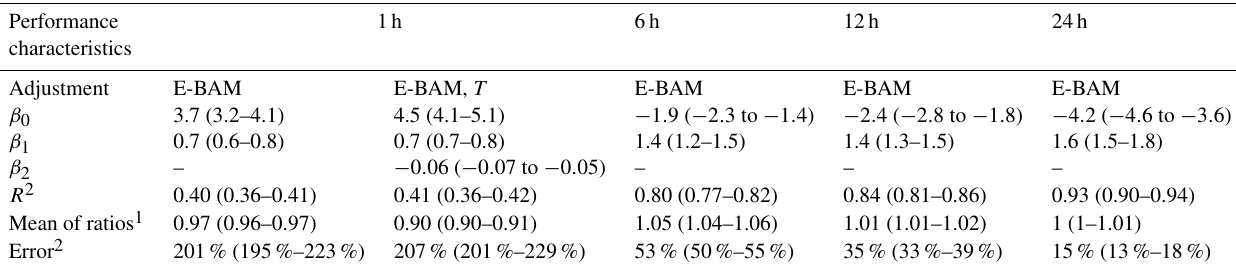
Figure 4. Linear regressions between aggregated PM2.5 mass concentrations (µgm − 3 ) of the E-BAM and the five uncalibrated PMS3003 sensors at 1 and 24h time intervals from 1 February to 31 March 2017 at Duke University (6 and 12h results not shown). Marginal rugs were added to better visualize the distribution of data on each axis. Table 2. Summary of sensor performance characteristics for the five PMS3003 PM 2 . 5 measurements at 1, 6, 12, and 24h time intervals from 1 February to 31 March 2017 at Duke University. The fit coefficients for the calibration models are provided. The R 2 , mean of ratios, and error are performance characteristics for the calibrated sensor PM 2 . 5 measurements in comparison with reference values. The results are displayed in mean (range) format. Note the mean statistics were obtained by fitting the models to the PMS3003 PM 2 . 5 measurements averaged across all five sensor package units at each point in